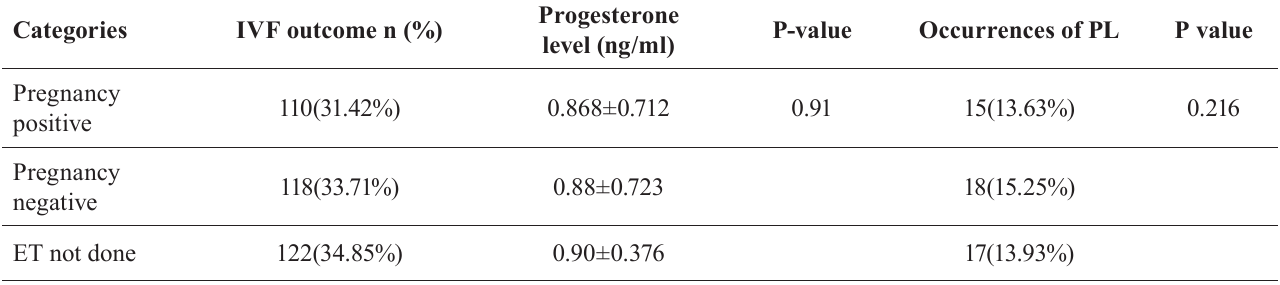
TABLE IV - Level of progesterone in patients with no Embryo transfer occurred